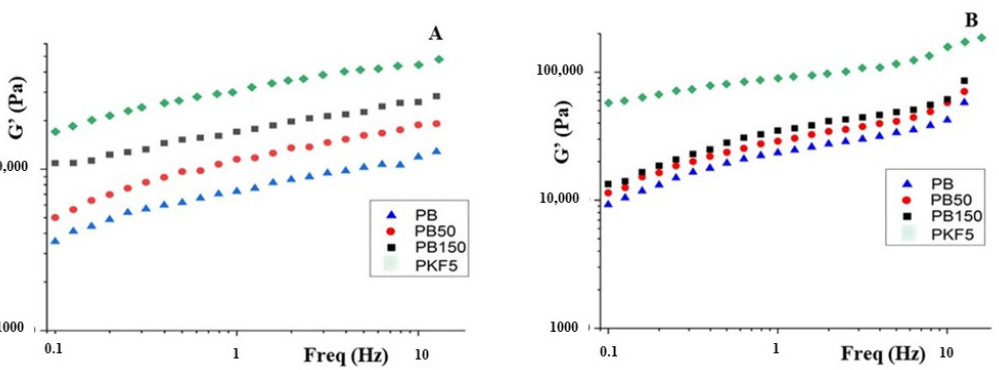
Figure 3. Frequency sweep test of the gluten-free doughs before leaving ( A ) and after 3.5 h of leaving ( B ). It can be noted that the elastic modulus (G’), although maintaining the same frequency profile, increases when there is a quantity of kefir greater than 50 mL in the mixture (samples PKB50 and PKB150), reaching maximum values when the antioxidant extract was added (sample PKF5). This rheological behavior is indicative of a greater structuring of the doughs, in terms of the greater interaction strength between the links of the formed